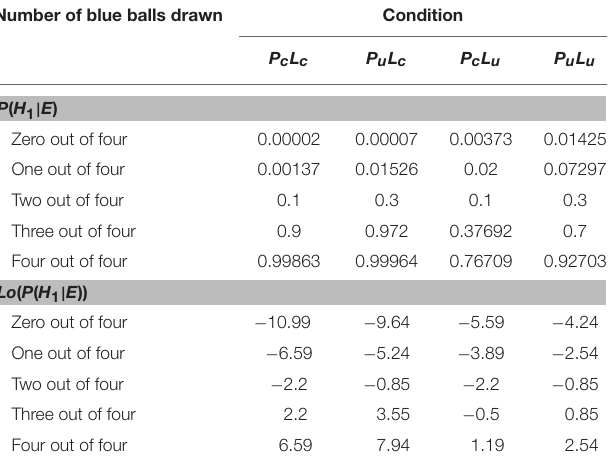
TABLE 1 | Posterior probability for the rare urn P ( H 1 | E ) and Lo ( P ( H 1 | E )) for different conditions and different ball samples drawn. Number of blue balls